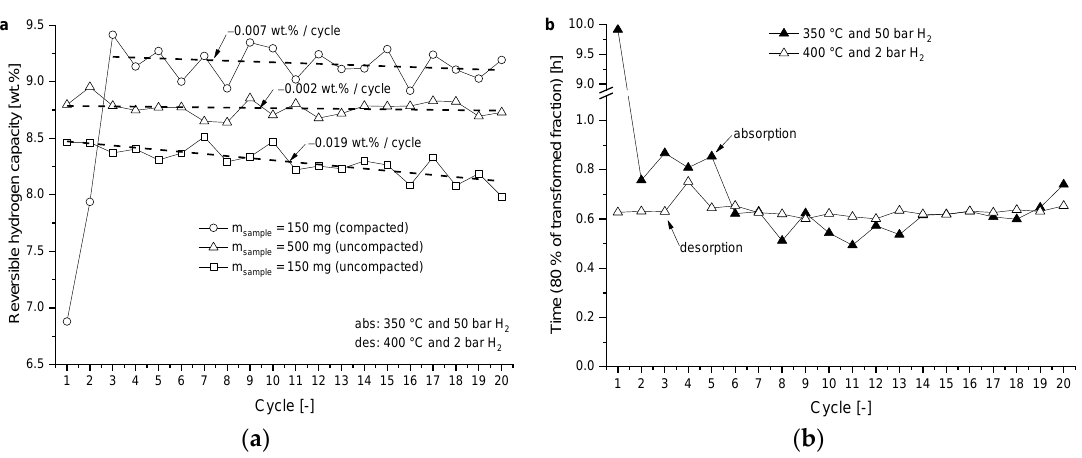
Figure 4. ( a ) Quantity of hydrogen desorbed at 400 °C and 2 bar H 2 upon cycling, for different amounts of compacted/uncompacted samples after absorption at 350 °C and 50 bar H 2 ; ( b ) Time for absorption and desorption of 80% transformed fraction upon cycling for the 500 mg sample.